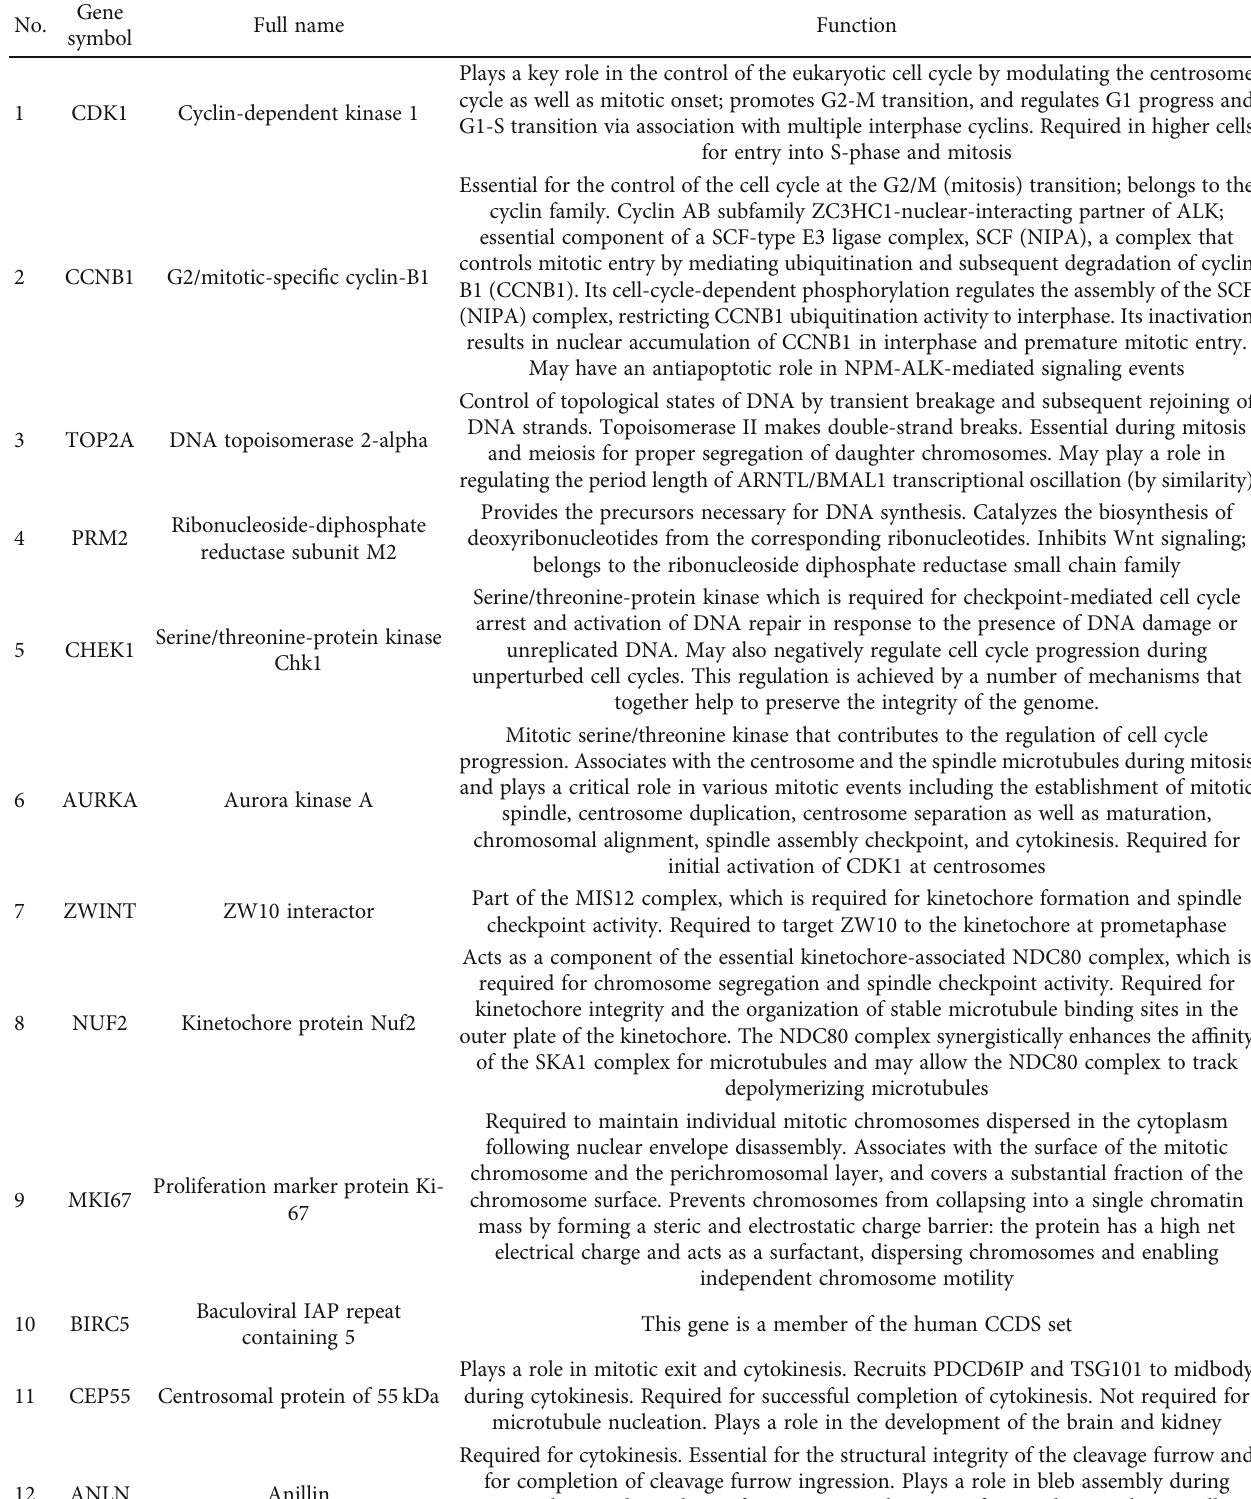
Table 3: Functional roles of 16 hub genes with degree ≥ 10